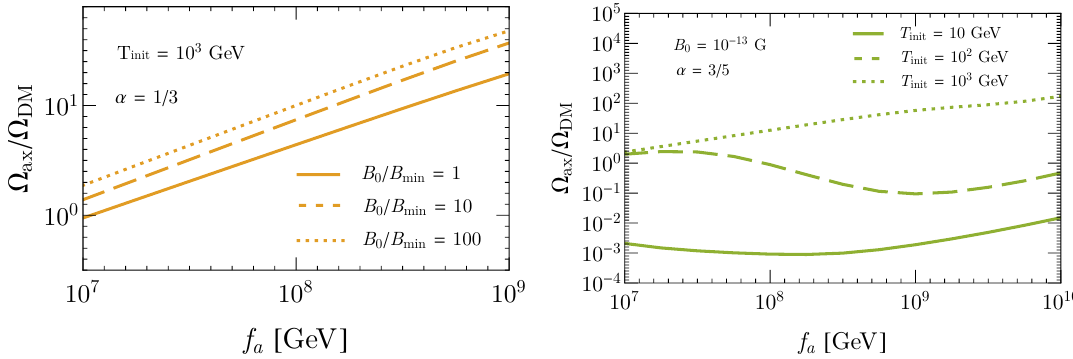
Figure 9 . Ω ax / Ω DM as a function of f a for a fixed T init and B 0 today, scaled by the observed lower bound B 10 − 13 G, for the causal PMF. Left : α = 1 / 3 and we change B min ≡ Ω behaves for T = 10 3 GeV. Right : α = 3 / 5 and we change T ax init B 0 = B min